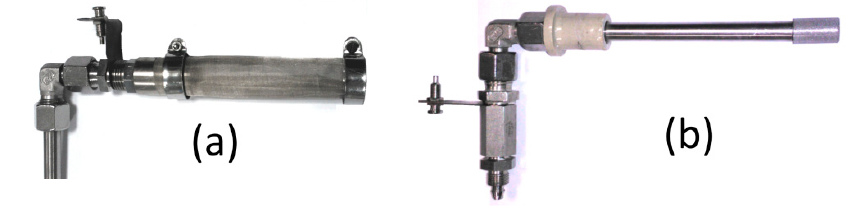
Figure 4. View of the anode ( a ) and cathode ( b ) of the Model II MH-DCFC.